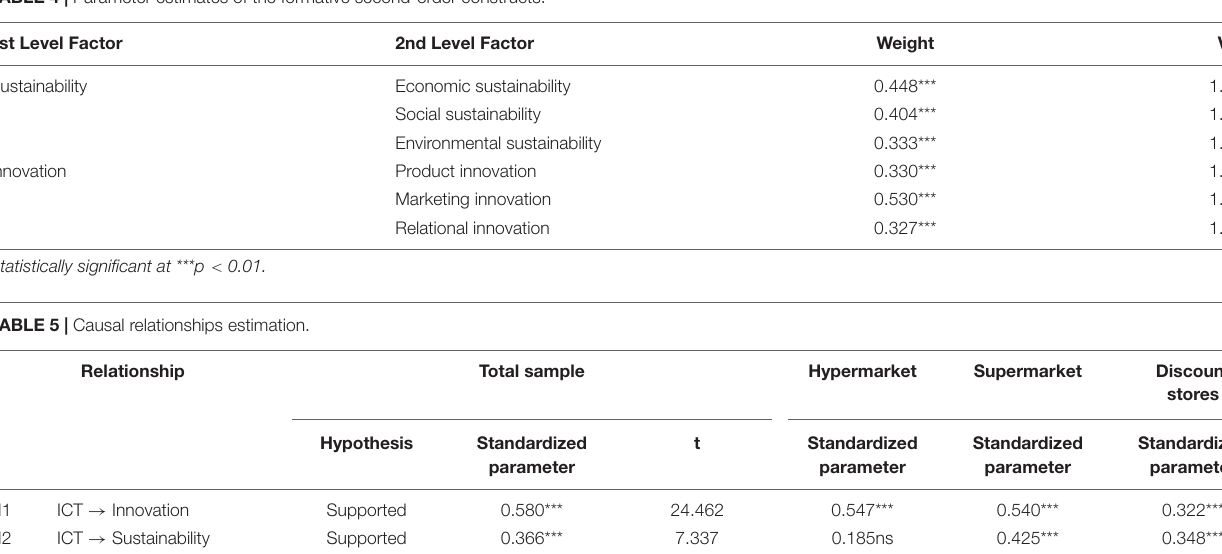
TABLE 4 | Parameter estimates of the formative second-order constructs.